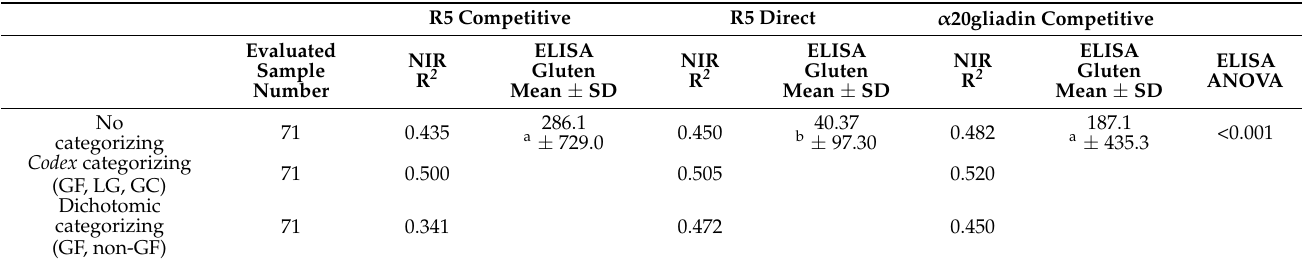
Table 5. Evaluation of gluten content or gluten-containing products discrimination of beer cohort by three different enzyme-linked immunosorbent assay and correlation statistics of each one by near-infrared